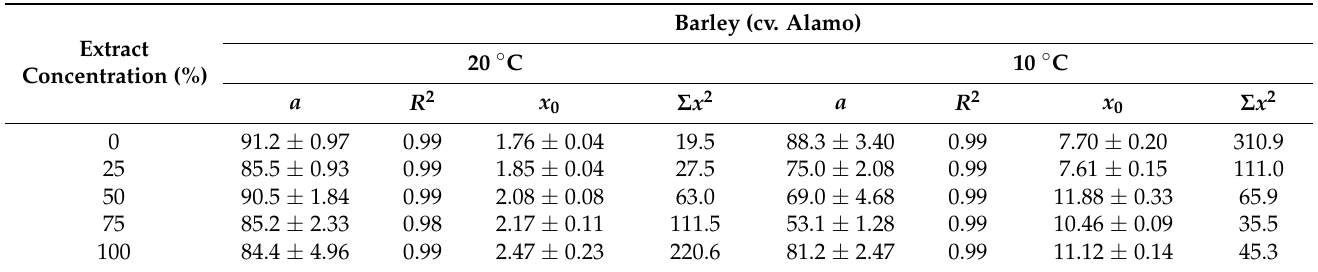
Table 3. Values of parameters of the sigmoidal logistic function interpolating data of seed germination at 20 and 10 ◦ C in barley cv. Alamo under different hemp leaf extract